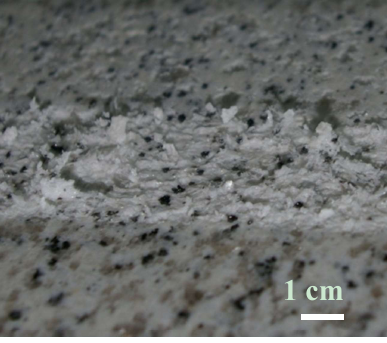
Figure 5. Flakes formed during the laser blasting of white granite remain adhered to the surface due to their melting.